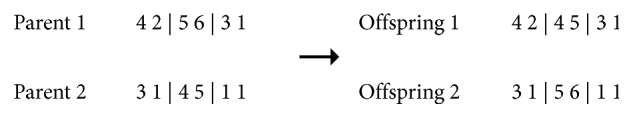
Machine crossing.